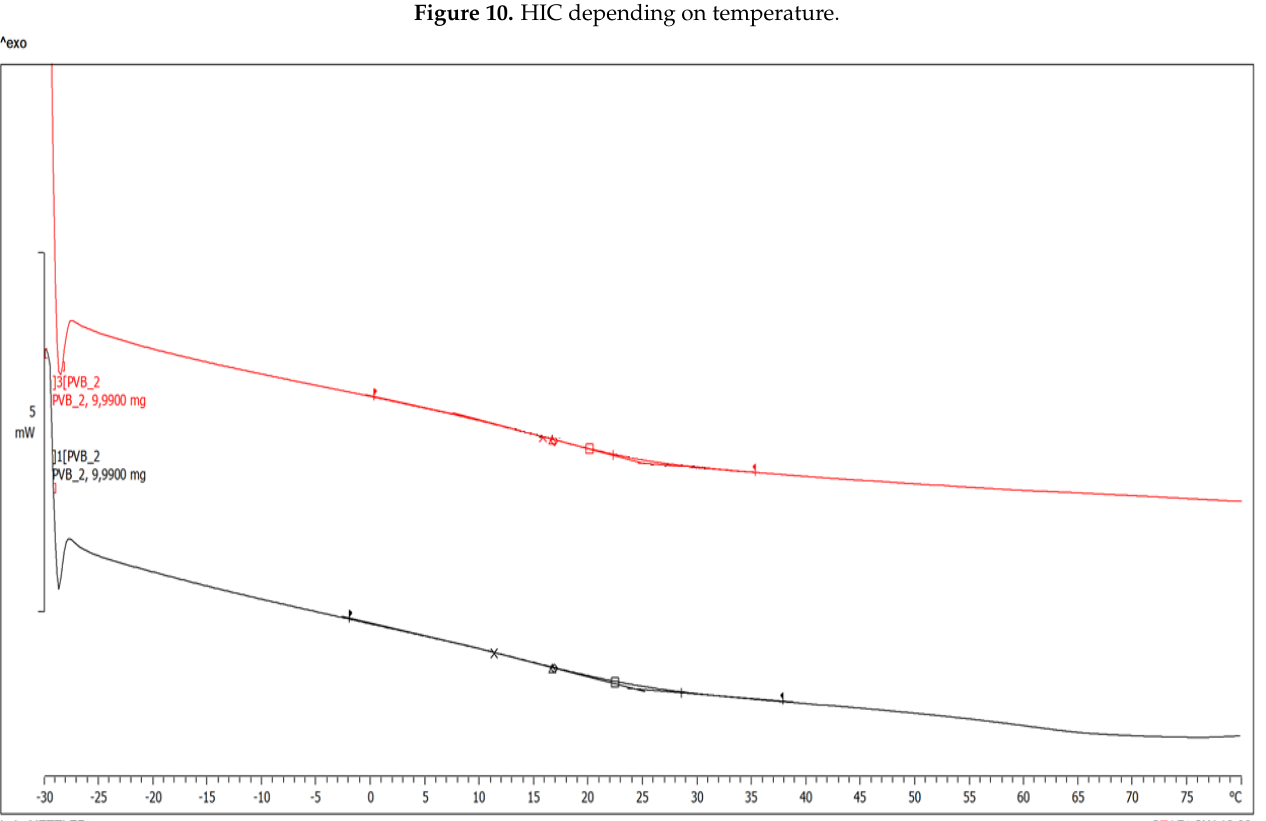
Figure 11. PVB DSC Figure 11. PVB DSC curves. Table 2. Figure 11 curves output values.